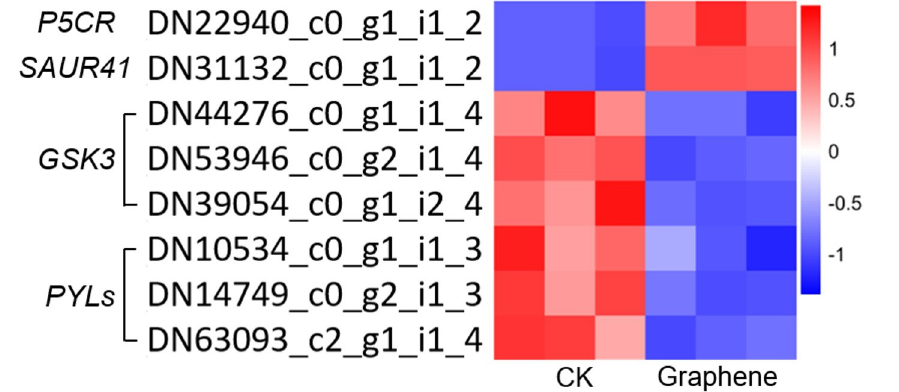
Fig 8. Selected DEGs promote root growth in response to